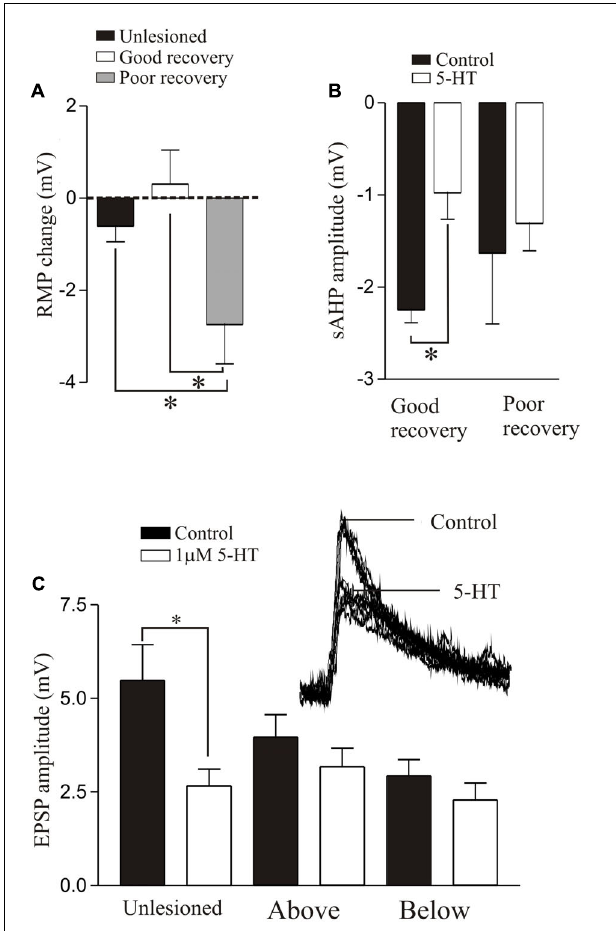
FIGURE 8 | 5-HT-mediated modulation after lesioning. (A) Graph showing the effects of 5-HT on the resting membrane potential in unlesioned animals, and lesioned animals that showed good and poor recovery. (B) Graph showing the effects of 5-HT on the sAHP in good and poor recovery: note the amplitude was only significantly reduced in animals that showed good recovery. (C) Graph showing the effects of 5-HT on glutamatergic synaptic inputs in unlesioned animals and lesioned animals above and below the lesion site. The inset shows the effect of 5-HT in an unlesioned spinal cord. Data from Becker and Parker (2015). No permission is required to reproduce this material. ∗ Indicates statistical significance at p <